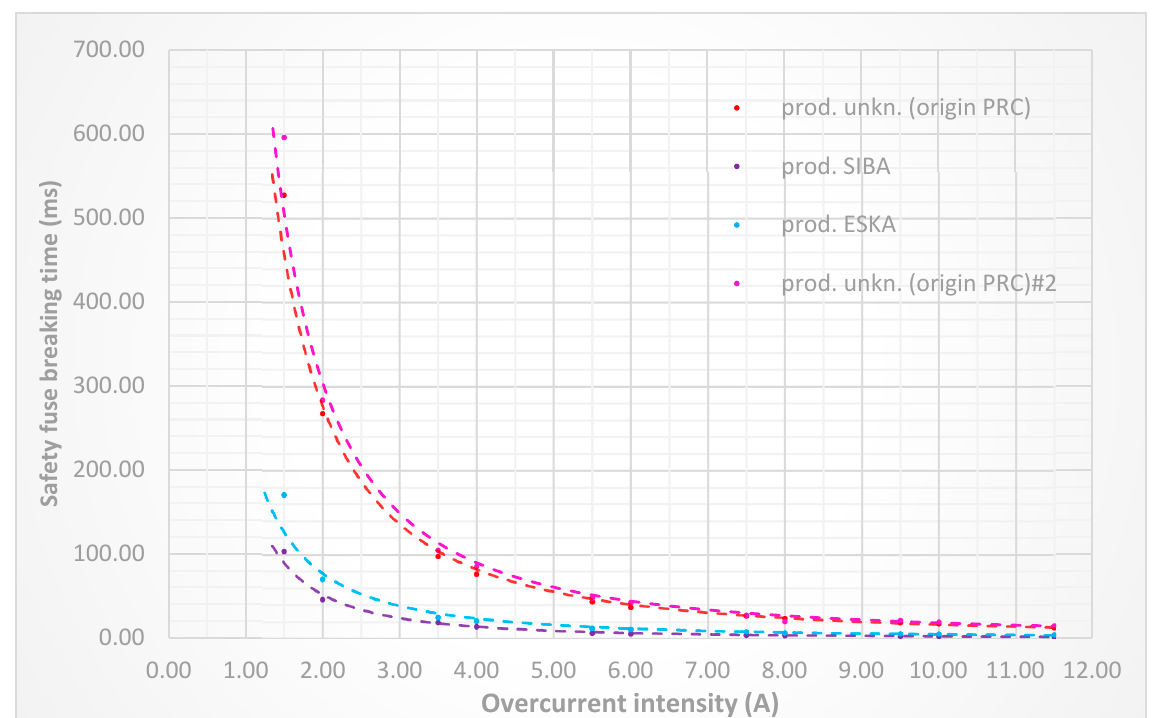
Figure 3. Time–current characteristics of the studied miniature fuse-links.